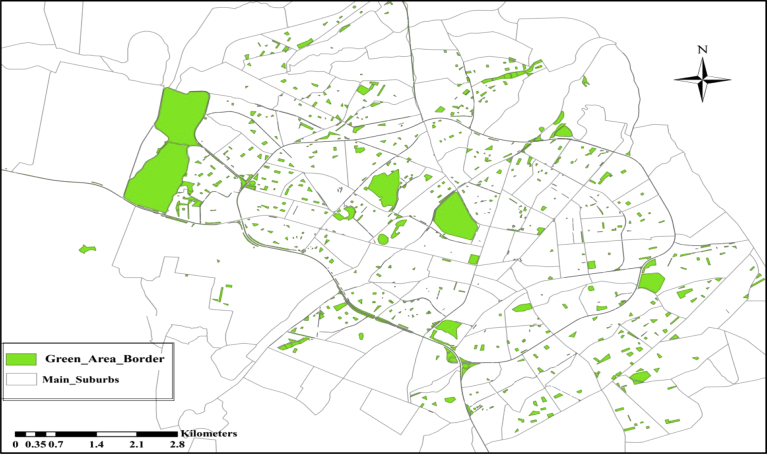
Green areas in sulaimania city (Sulaimani Municipality - Gardens DEPT., 2017).